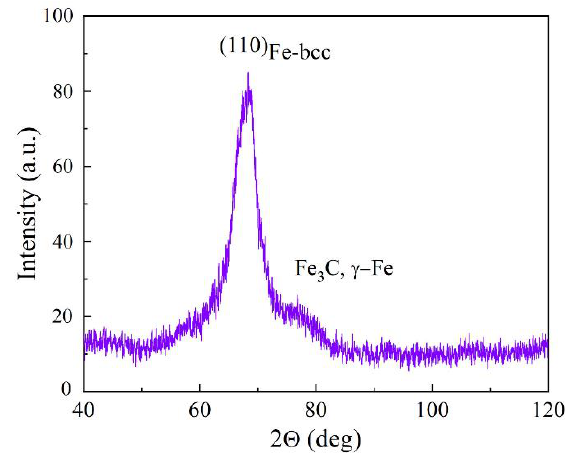
Figure 2. Result of XRD study of Fe@C nanoparticles, obtained with the CrK- α radiation.